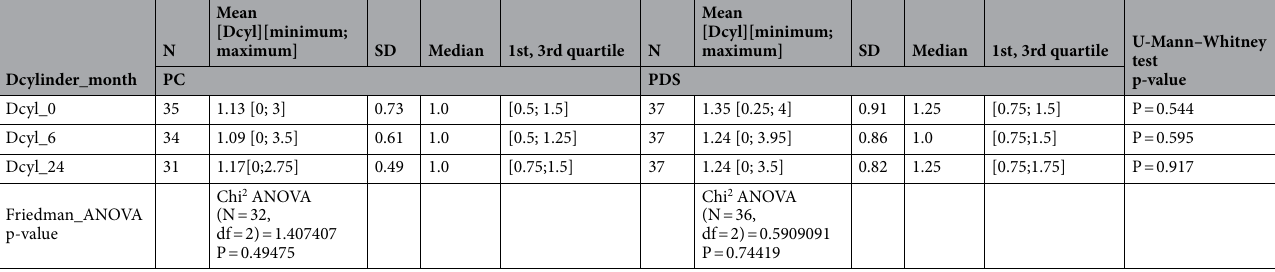
Table 2. Arithmetic mean of astigmatism. Results of statistical analysis between the groups (U-Mann Whitney Test) as well as for separate groups in analyzed time points (Friedman ANOVA). Statistical significance for P < 0.05.